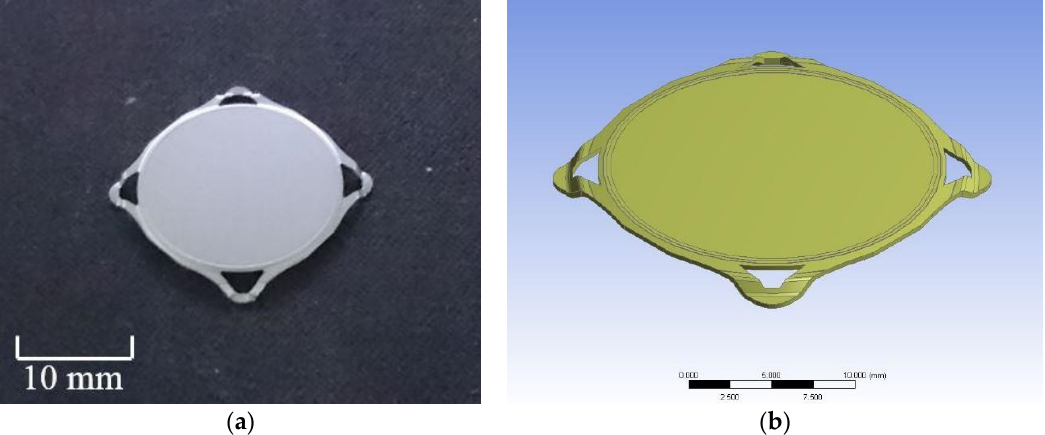
Figure 5. PBGA heat sink cap ( a ) real sample ( b ) model created using ANSYS.